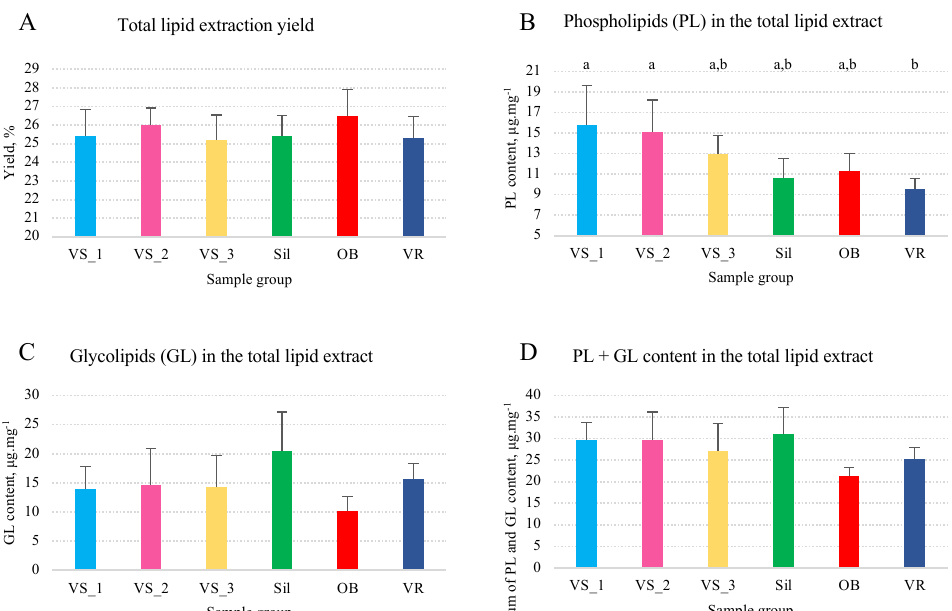
Figure 1. Content of total lipids ( A ), phospholipids ( B ), glycolipids ( C ), and phospholipids plus glycolipids ( D ) in olive seeds from different sub-regions of Nelas, Portugal. Different superscript letters in ( B ) indicate significant differences between groups (one-way ANOVA, Tukey’s HSD post hoc analysis, p < 0.05). Samples were collected from six olive orchards located in Vilar Seco_1 (VS_1), Vilar Seco_2 (VS_2), Vilar Seco_3 (VS_3), Silgueiros (Sil), Oliveira de Barreiros (OB), and Vila Ruiva (VR).